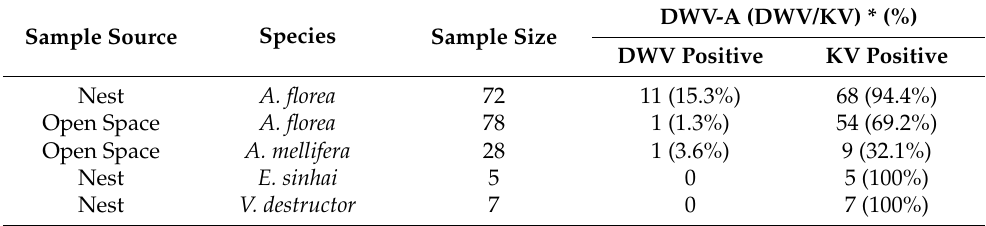
Table 4. Prevalence of DWV-A in Apis florea , Euvarroa sinhai , A. mellifera and Varroa destructor